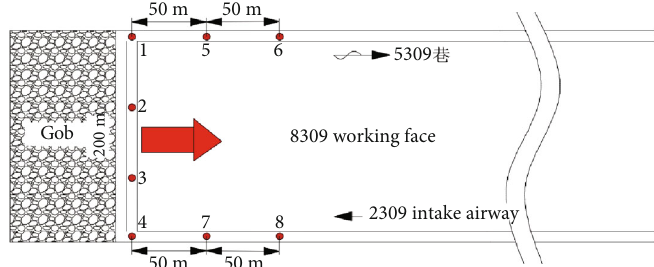
Figure 1: Layout of CO measuring points in panel 8309.